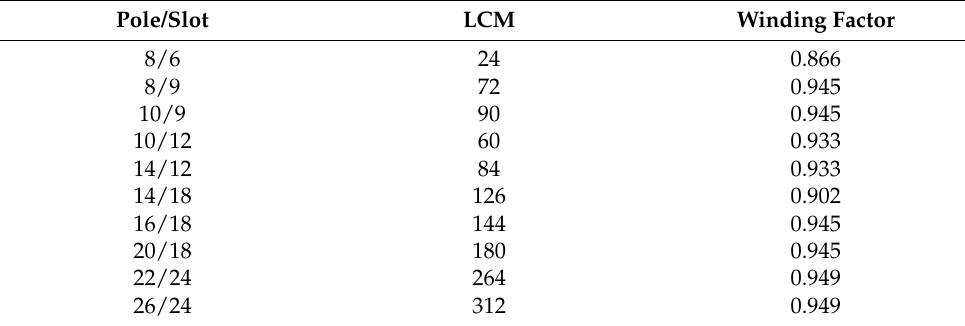
Table 1. LCM values and winding factors for pole–slot combinations. Pole/Slot LCM Winding